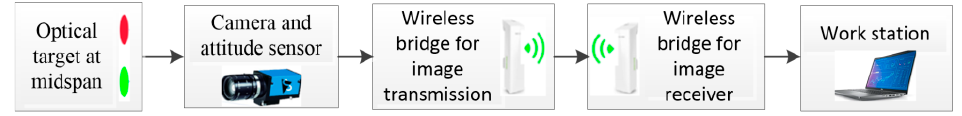
Figure 11. Vision-based system for relative sag measurement.